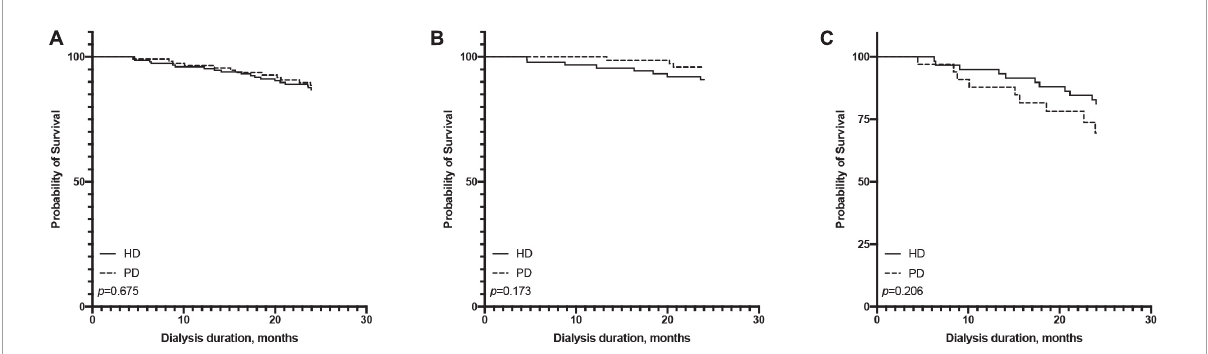
FIGURE4 Comparison of first 2 years survival rate between hemodialysis and peritoneal dialysis by age subgroups [ (A) all patients, (B) ≤ 65 years old group, (C) > 65 years old group].